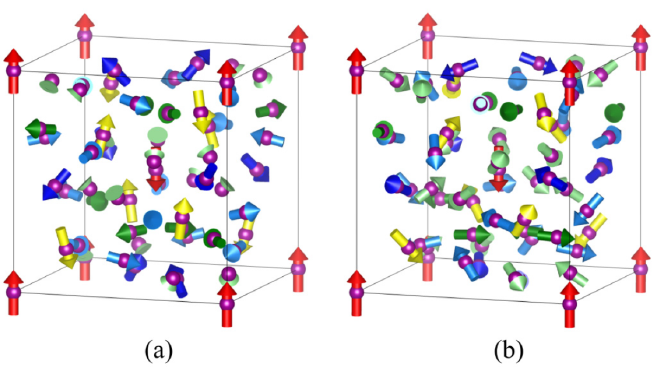
Figure 3. SCAN-generated noncollinear magnetic structure of various α -Mn sublattices: I (red), II (yellow), IIIa (blue), IIIb (light blue), IVa (green), and IVb (light green). ( a ) Only the atomic positions are relaxed. ( b ) Both the atomic positions and the cell shape are relaxed. The figure is adapted from Ref.